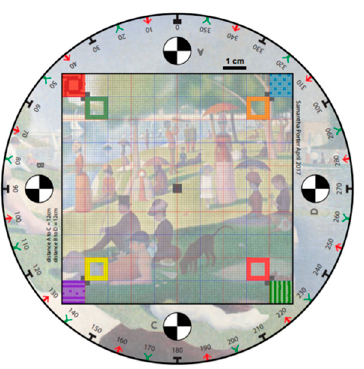
Figure 1. A calibration chart used to differentiate specific reference points.